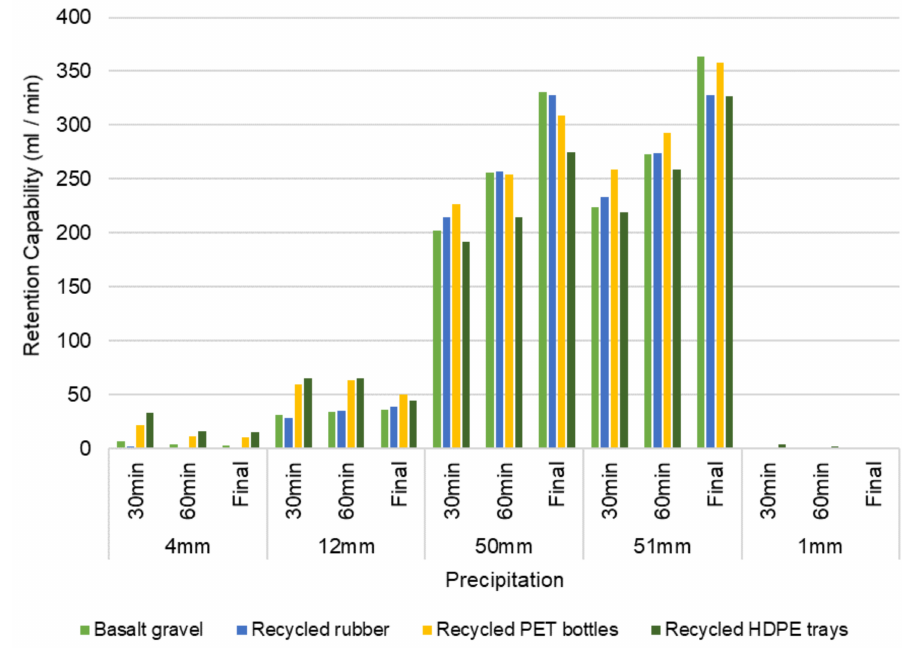
Figure 8. Average behavior of drained water (mL / min) for typical rain conditions between post-drought and stable cycles.